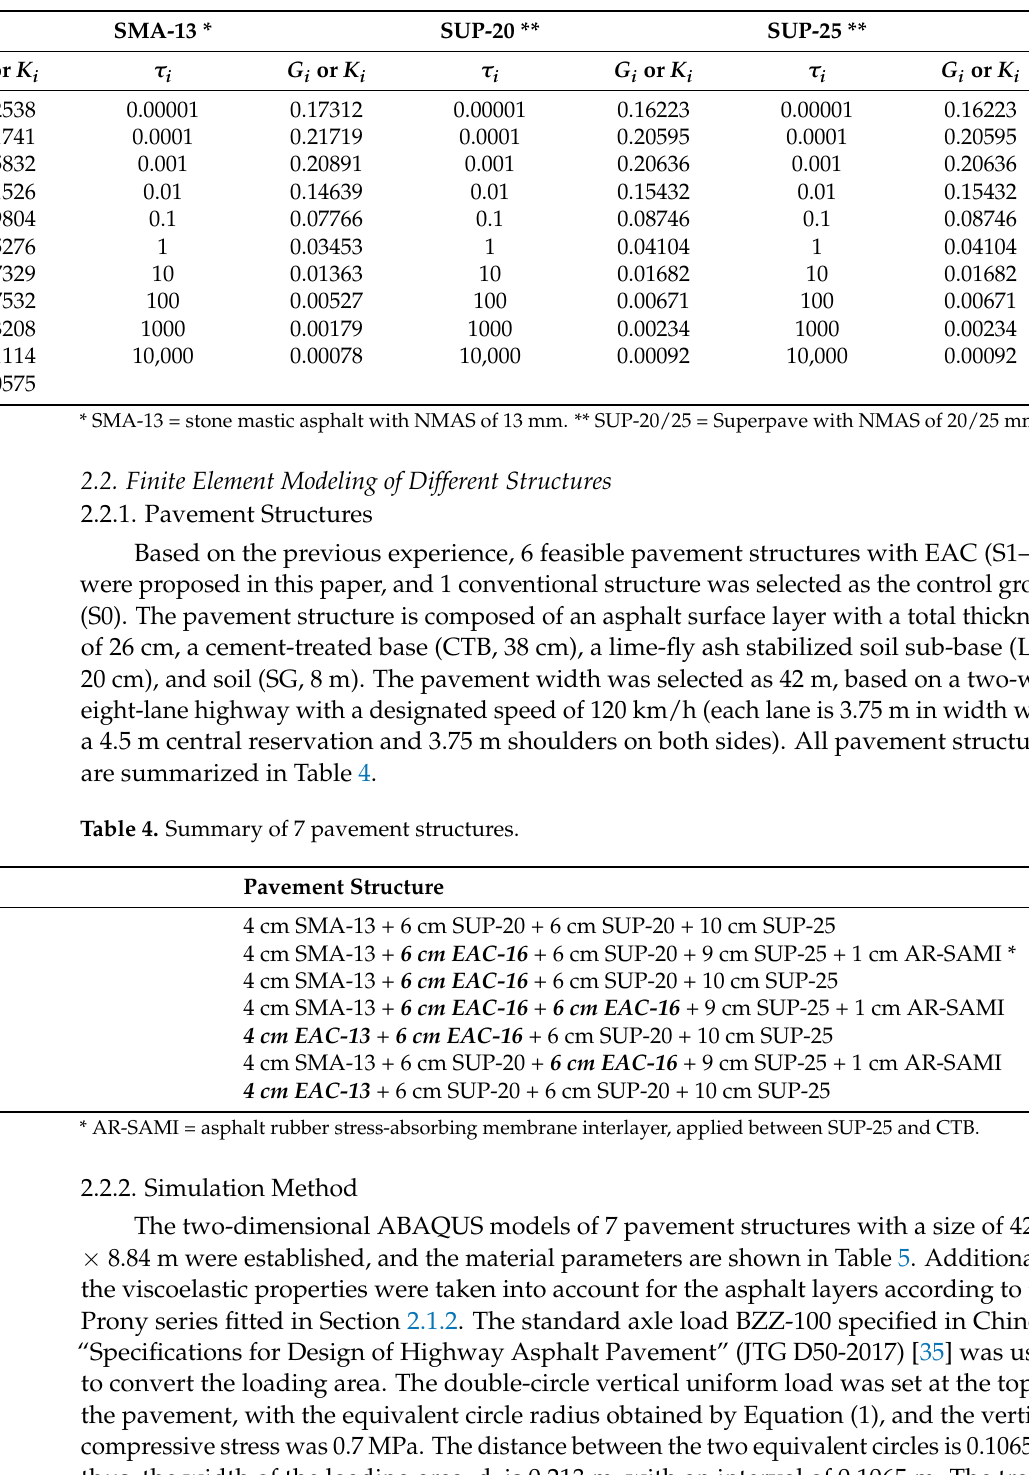
Table 3. Prony series parameters of EAC and other asphalt mixtures.